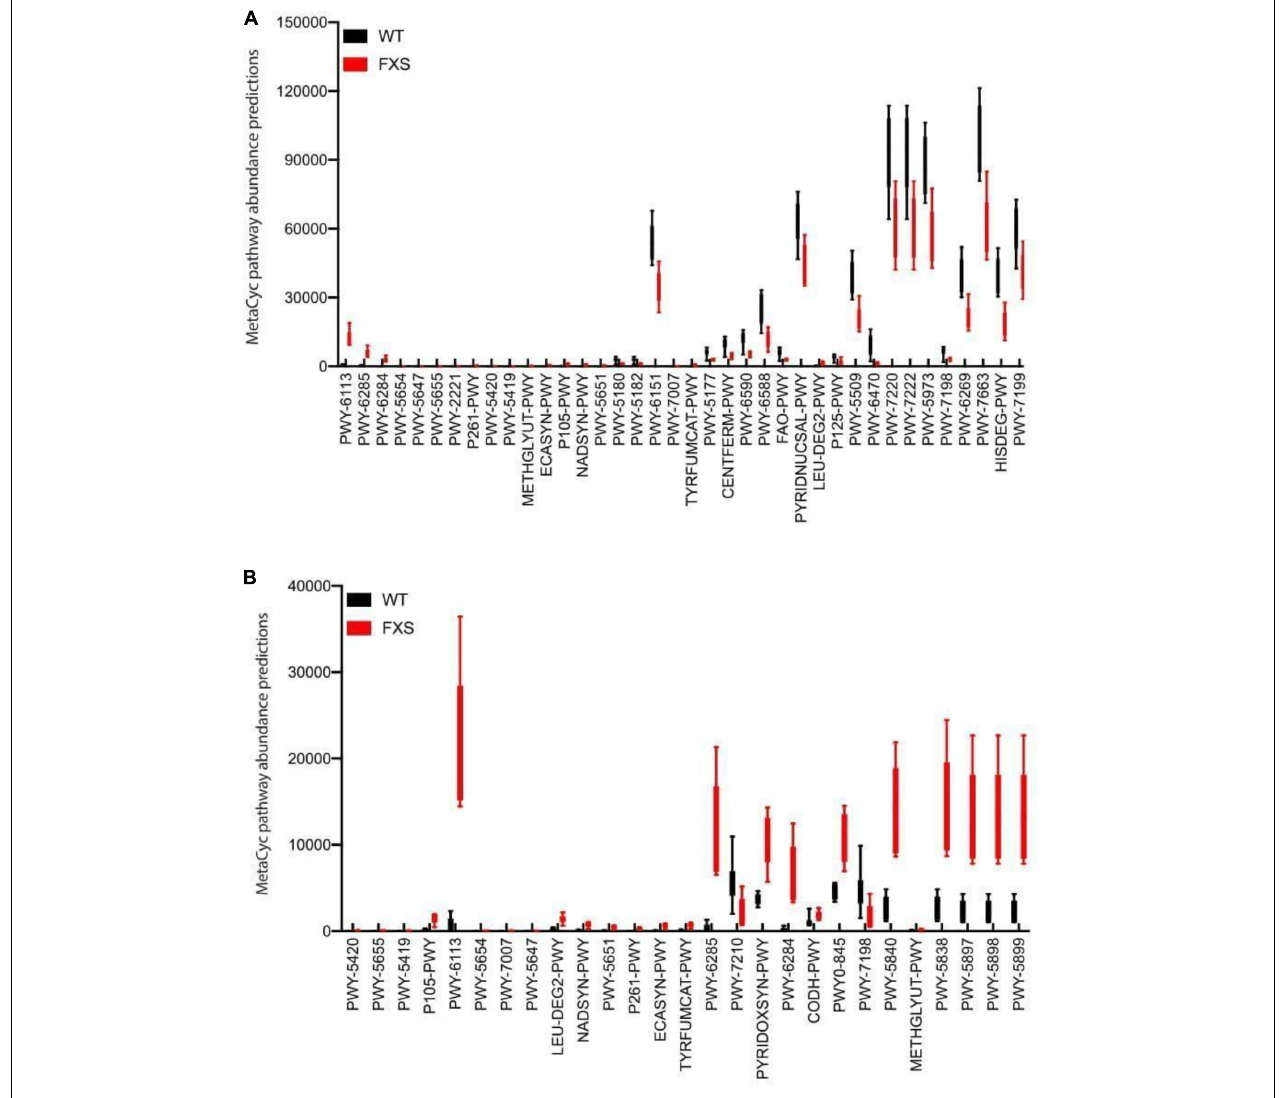
FIGURE 3 | Microbial metabolic pathway prediction on the fmr1 KO2 mouse gut microbiome. Samples from cecum (A) and feces (B) were analyzed for the prediction of significantly altered metabolic